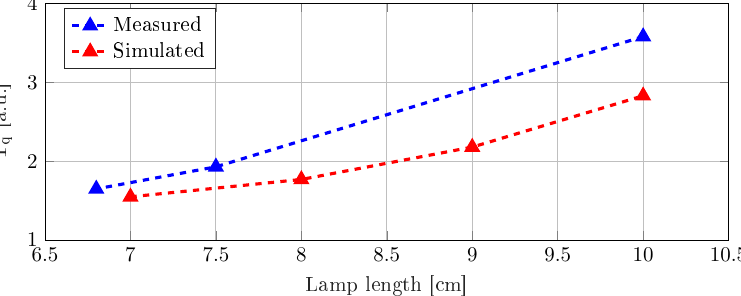
Figure 7. Comparison of the simulation and measurements of the temperature quotient T q